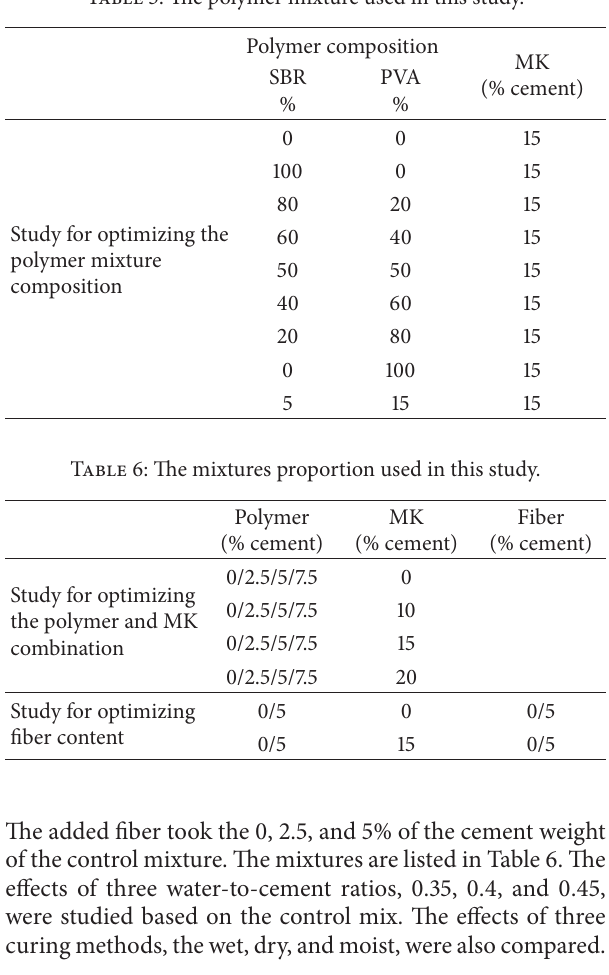
Table 5: The polymer mixture used in this study.